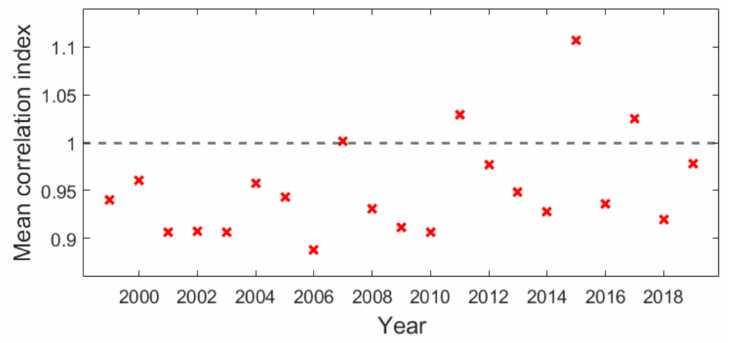
Figure 2. Yearly mean of all ERA5T correlation indices for the 77 sites.